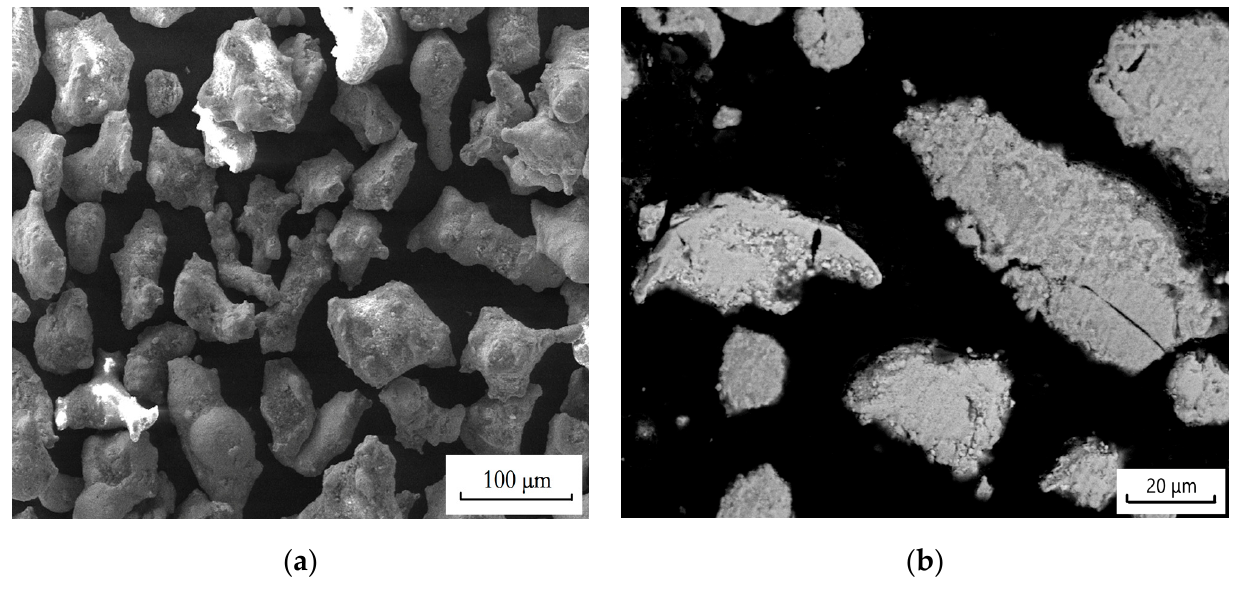
Figure 2. Microstructure of polypropylene powder: ( a ) globular; ( b ) Cross-sectional.